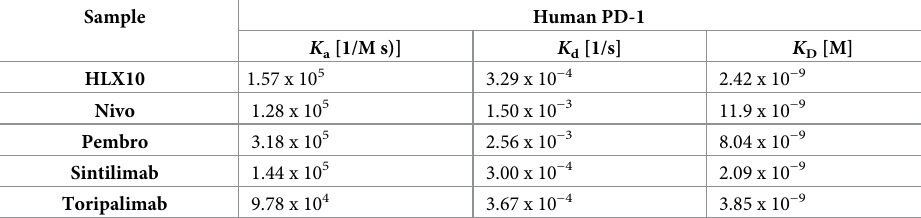
Table 1. Kinetics and binding affinities of anti-PD-1 antibody to human PD-1 determined by BLI.